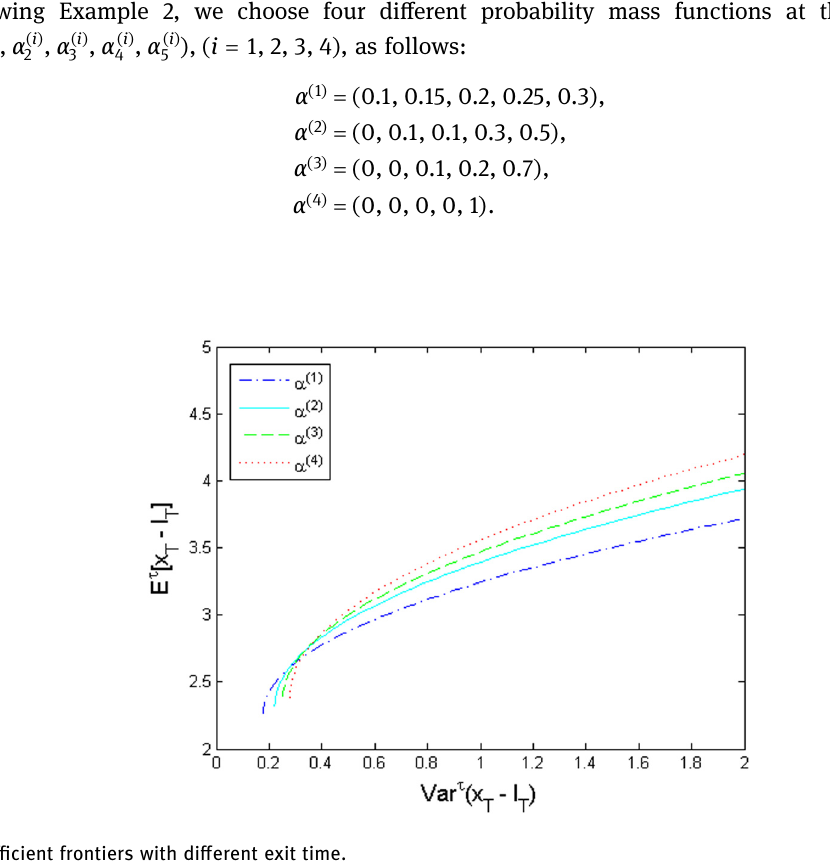
Figure 2: E ffi cient frontiers with di ff erent exit